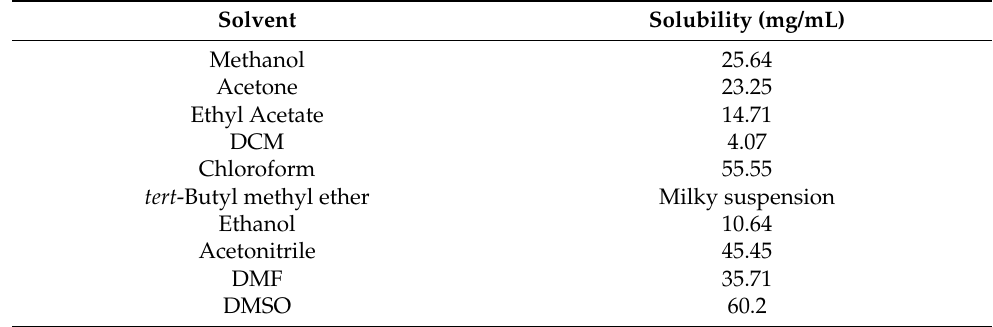
Table 1. Solubility of APT in various organic